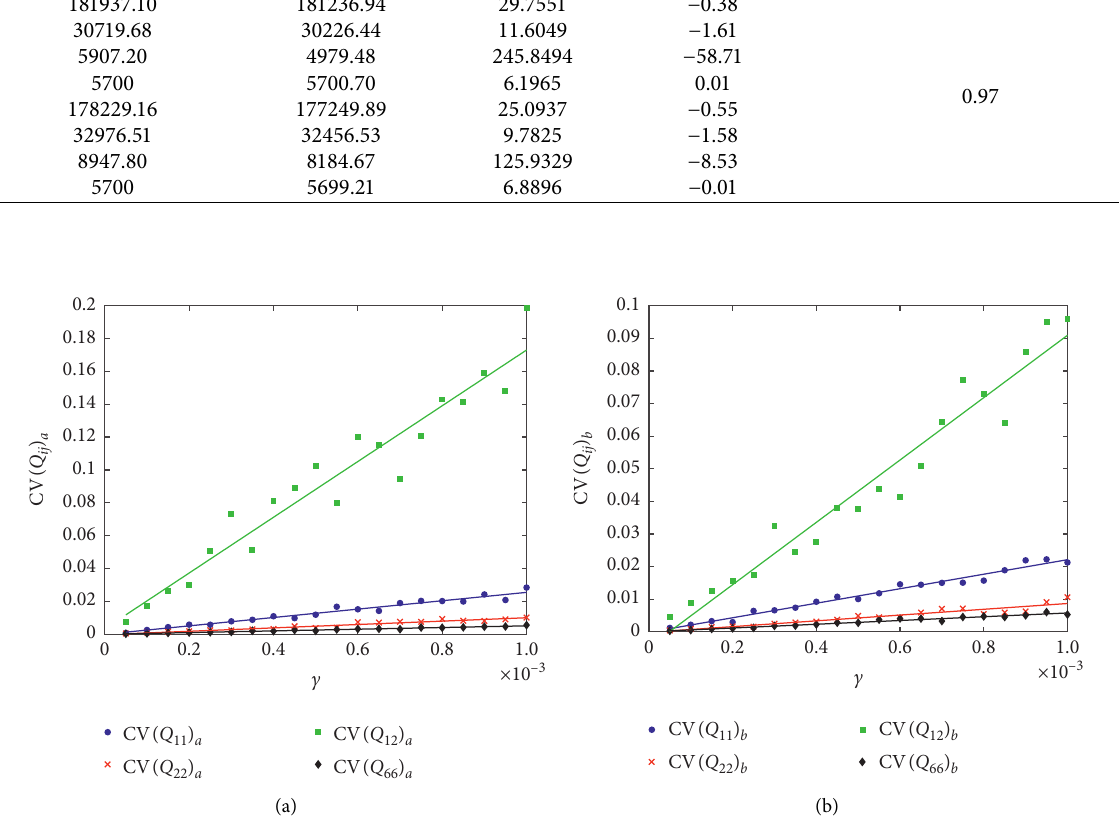
Figure 4: The coefficients of variation of the identified stiffness components. (a) Part A; (b) Part Table 5: The fitted and the theoretical values of the variation coefficient-to-noise ratios.